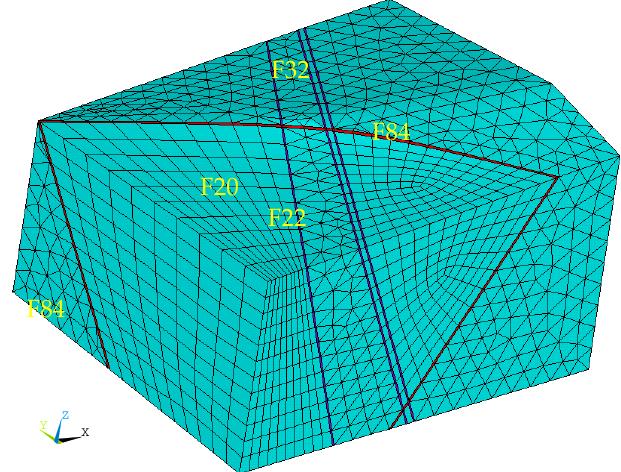
Figure 7. 3D FEM calculating model.